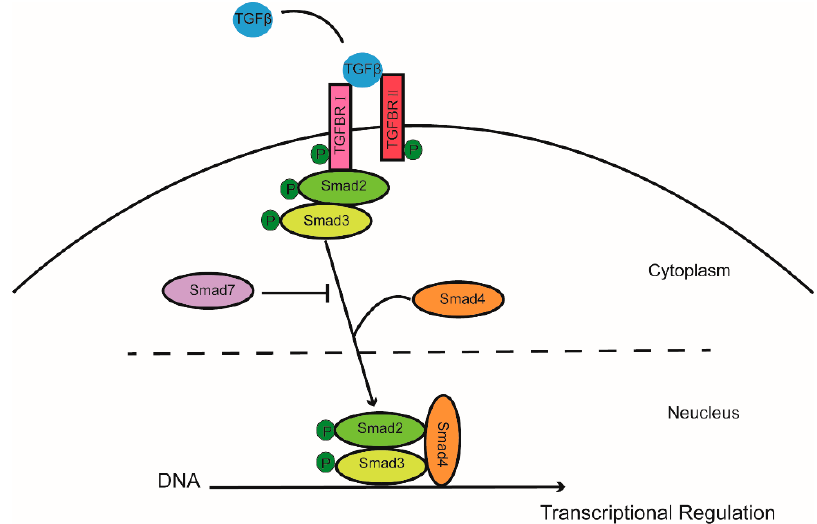
Figure 1. Canonical TGF β /SMAD signaling pathway. TGF β binds to type II receptors on the cell membrane, recruiting type I receptors to phosphorylate Smad2 and Smad3 (R-Smad) to form a complex with Smad4. The complex then translocates from the cytoplasm to the nucleus and regulate downstream gene expression.